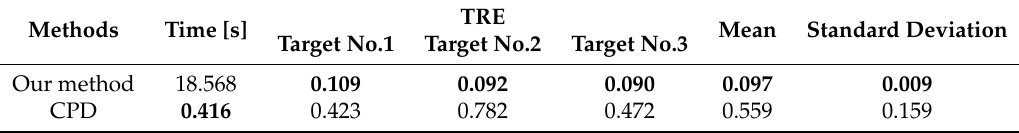
Figure 5. Clinical data before and after registration. ( a ) The initial relative position of the two point sets to be registered. ( b ) The result of our method. ( c ) The result of CPD. Table 1. The results of registration on the clinical